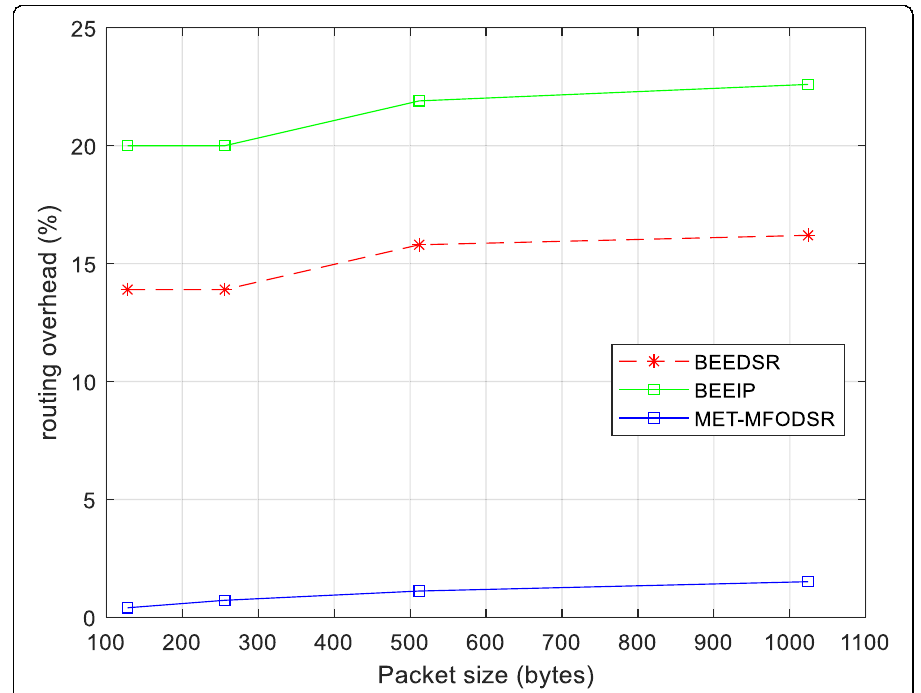
Fig. 7 Routing overhead simulation results for BEEDSR, BeeIP, and MET-MFODSR. The simulation results of the routing overhead under the packet size variation